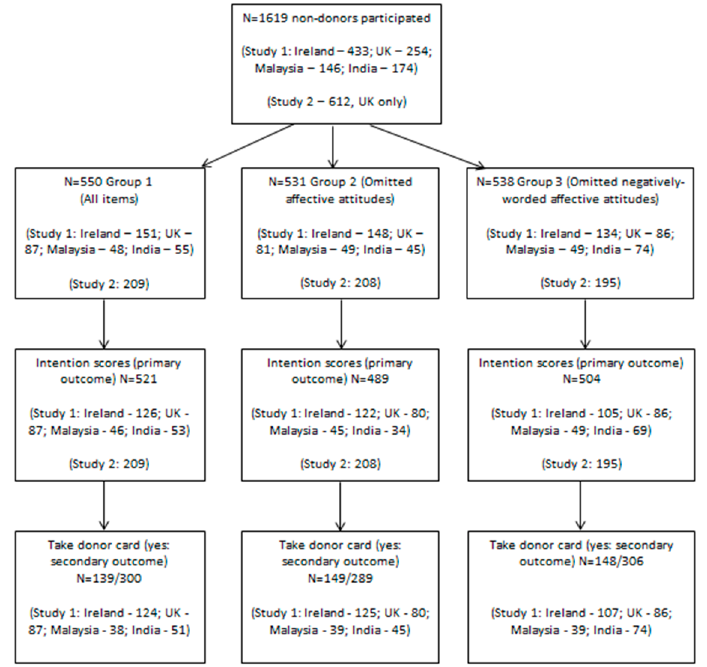
Figure 1. Participant flowchart and outcome ascertainment.